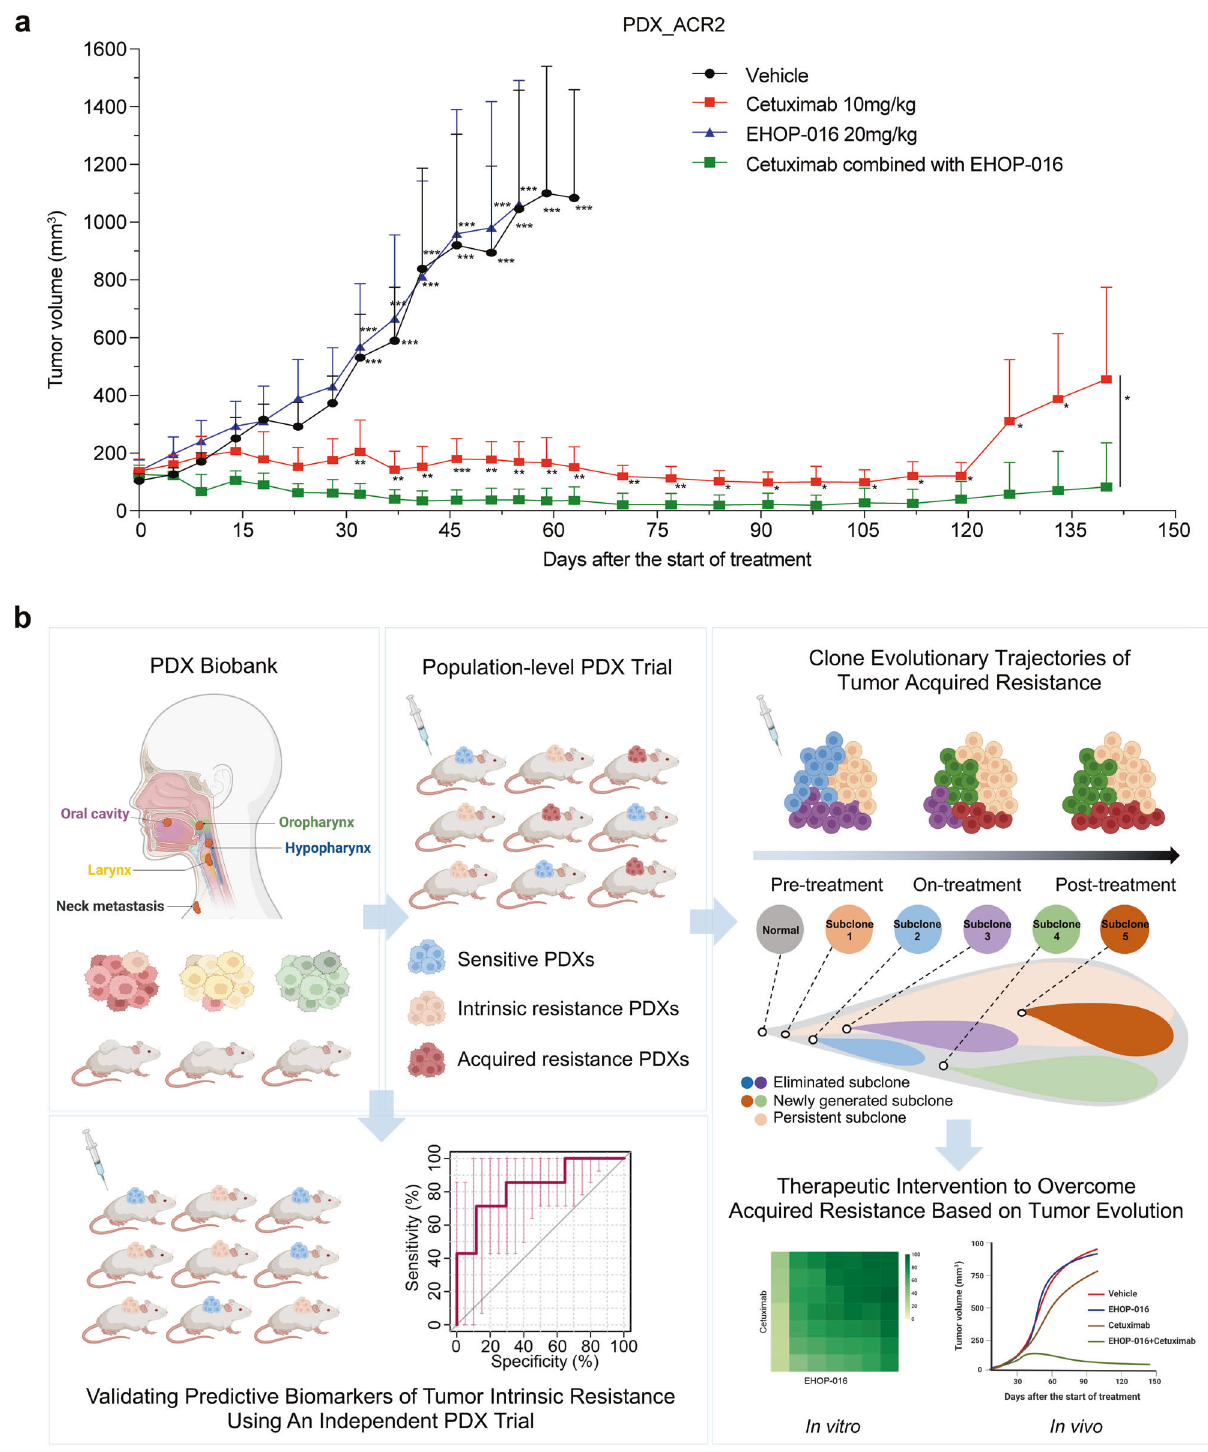
Fig. 8 Long-term combined treatment overcame acquired resistance to cetuximab and inhibited tumor recurrence. a More than 4 months after the start of treatment, the tumor growth curves in the cetuximab-acquired resistance PDX model (PDX_ACR2) treated with solvent control, EHOP-016, and cetuximab, alone or in combination. n = 5 mice for each group. Mean tumor volumes ± SD are plotted. * P ≤ 0.05; ** P ≤ 0.01; *** P ≤ 0.001. b Schematic diagram of the clinical utility of PDX cohorts to reveal biomarkers of intrinsic resistance and clonal dynamics underlying acquired resistance to cetuximab in HNSCCs. Schematics were created with BioRender.com have actually supported revision of the NCCN guidelines for use of PDX tumor models driving the development of PCT studies is their cetuximab for CRCs. 48 In addition, several PCT studies revealed capability of capturing therapy-induced cancer progression. PCT studies of CRCs have validated KRAS mutation as an that mutations in genes including NRAS, BRAF, FGFR1 , and PIK3CA informative biomarker for cetuximab resistance; 21,47 these fi ndings (among others) are potential biomarkers for intrinsic resistance to Signal Transduction and Targeted Therapy (2022)